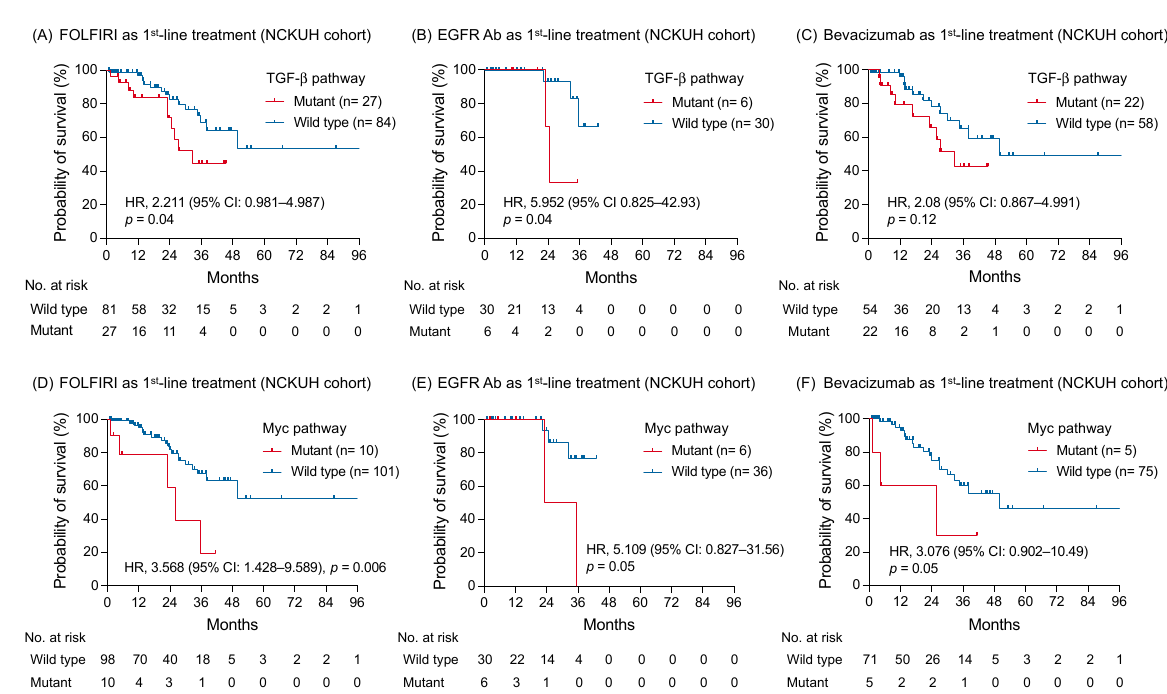
Figure 5. The correlation between altered signaling pathways and survival of patients with mCRC receiving disparate first-line treatment. The Kaplan-Meier survival curves of patients with and without genomic alterations of TGF- β pathway receiving FOLFIRI regimen ( A ), an anti-EGFR antibody ( B ), and bevacizumab ( C ) as first-line treatment. The association between the altered Myc pathway and survivals of patients receiving FOLFIRI ( D ), an anti-EGFR antibody ( E ), and bevacizumab ( F ) as first-line treatment were compared using a log-rank test, as well as the altered TGF- β pathway.